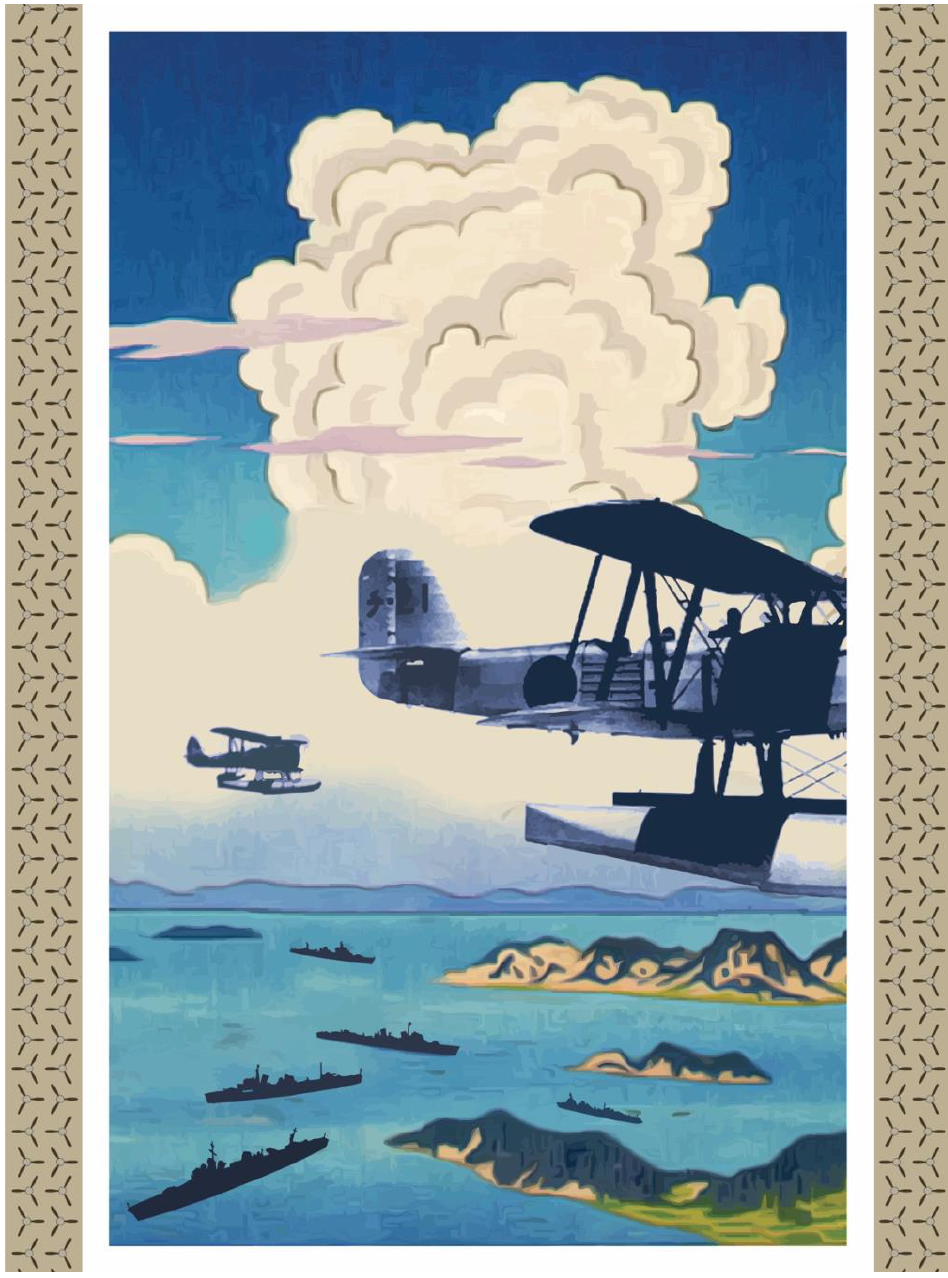
Kio Griffith, Eight Views of the Sun Setting on the South Pacific / Rabaul , 2021. Digital collage print on